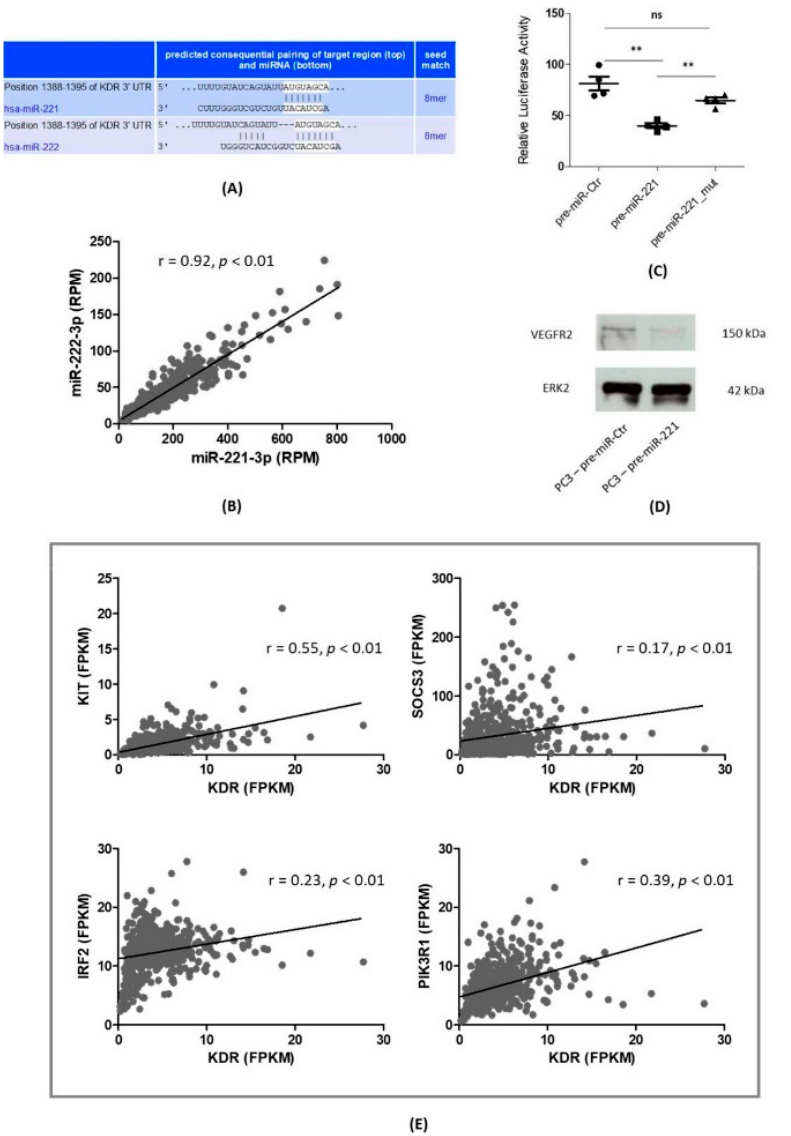
Figure 1. VEGFR2 / KDR is a direct target gene of miR-221-3p in PCa. ( A ) Bioinformatically Figure 1. VEGFR2/KDR is a direct target gene of miR ‐ 221 ‐ 3p in PCa. ( A ) Bioinformatically predicted KDR targeting sites (TargetScan.com) for miR ‐ 221 ‐ 3p and miR ‐ 222 ‐ 3p. ( B ) Markedly positive